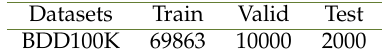
Table 2. Dataset training and test samples